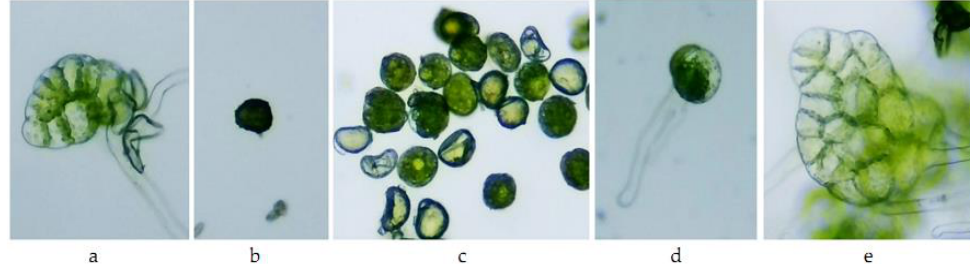
Figure 8. Asplenium scolopendrium gametophyte after 21 days of continuous exposure to Actellic 50 EC: ( a ) C (100 × )—prothallium blade; ( b ) A1 (100 × )—ungerminated spores; (c) A0.1 (100 × )—ungerminated spores, slightly swollen; ( d ) A0.01 (100 × )—germinated spores; and (e) A0.001 (100 × )—prothallium blade.